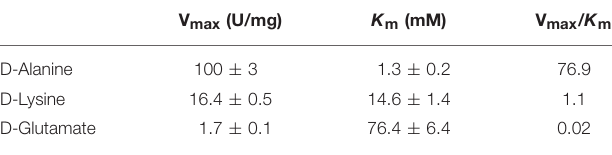
TABLE 2 | Comparison of the apparent kinetic parameters of RgDAAO on different substrates.